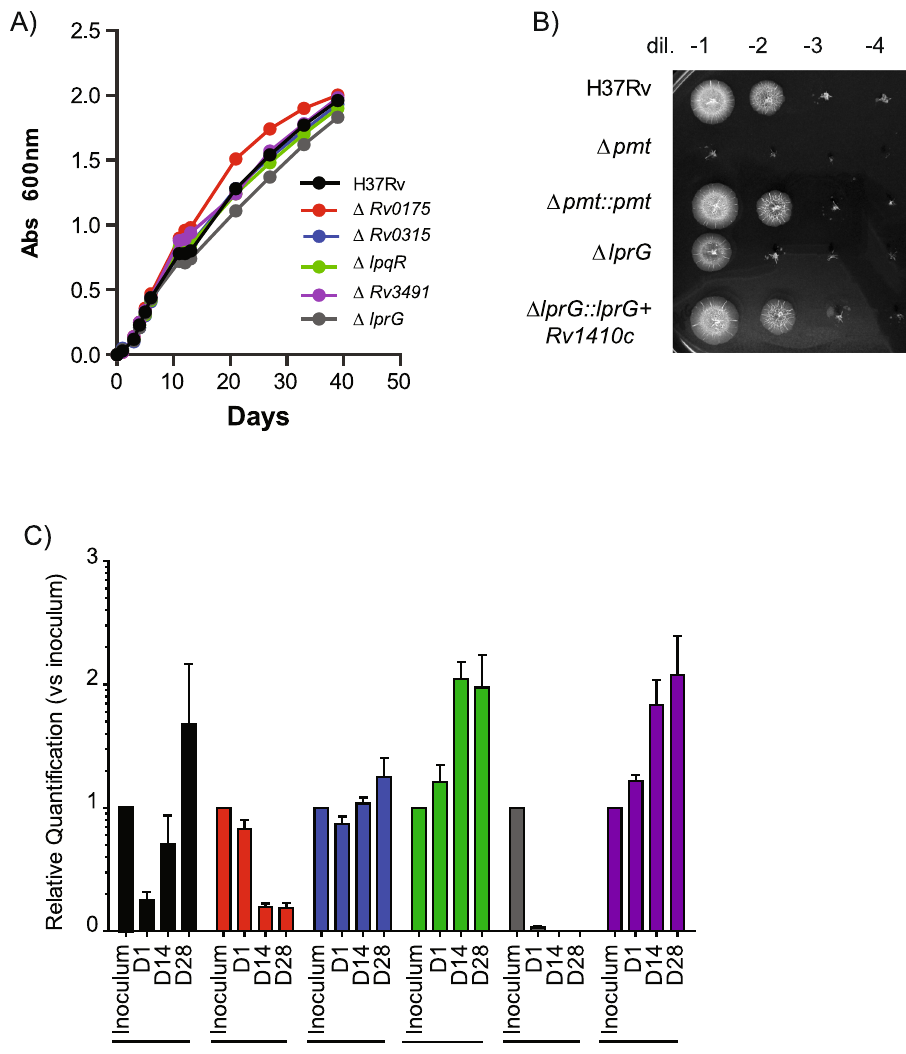
Figure 1. Contribution of selected mannoproteins to M . tuberculosis growth in vitro and in vivo . ( A ) Growth of WT M . tuberculosis and mutants in liquid medium. Mycobacterial strains were inoculated at 10 6 cfu/ml. Absorbance at 600 nm was followed over time for the various cultures. ( B ) Growth of WT M . tuberculosis and mutants on 7H11 Petri plates. Serial dilutions of adjusted liquid cultures of the various mutants were spotted on solid medium and incubated at 37 °C. ( C ) Growth of tagged-WT M . tuberculosis and tagged-mutants in BALB/c mice. Mice (5 for each time points) were infected with 6.10 2 cfu of a population containing similar concentration of each strains. At 1, 14 or 28 days post-infection, the bacterial population was recovered from the lung of the infected mice and grown for 7 days in liquid medium. Total DNA was extracted and the quantity of each mutant evaluated by qPCR using primers specific for the tags. The amount of each mutant relative to the inoculum is